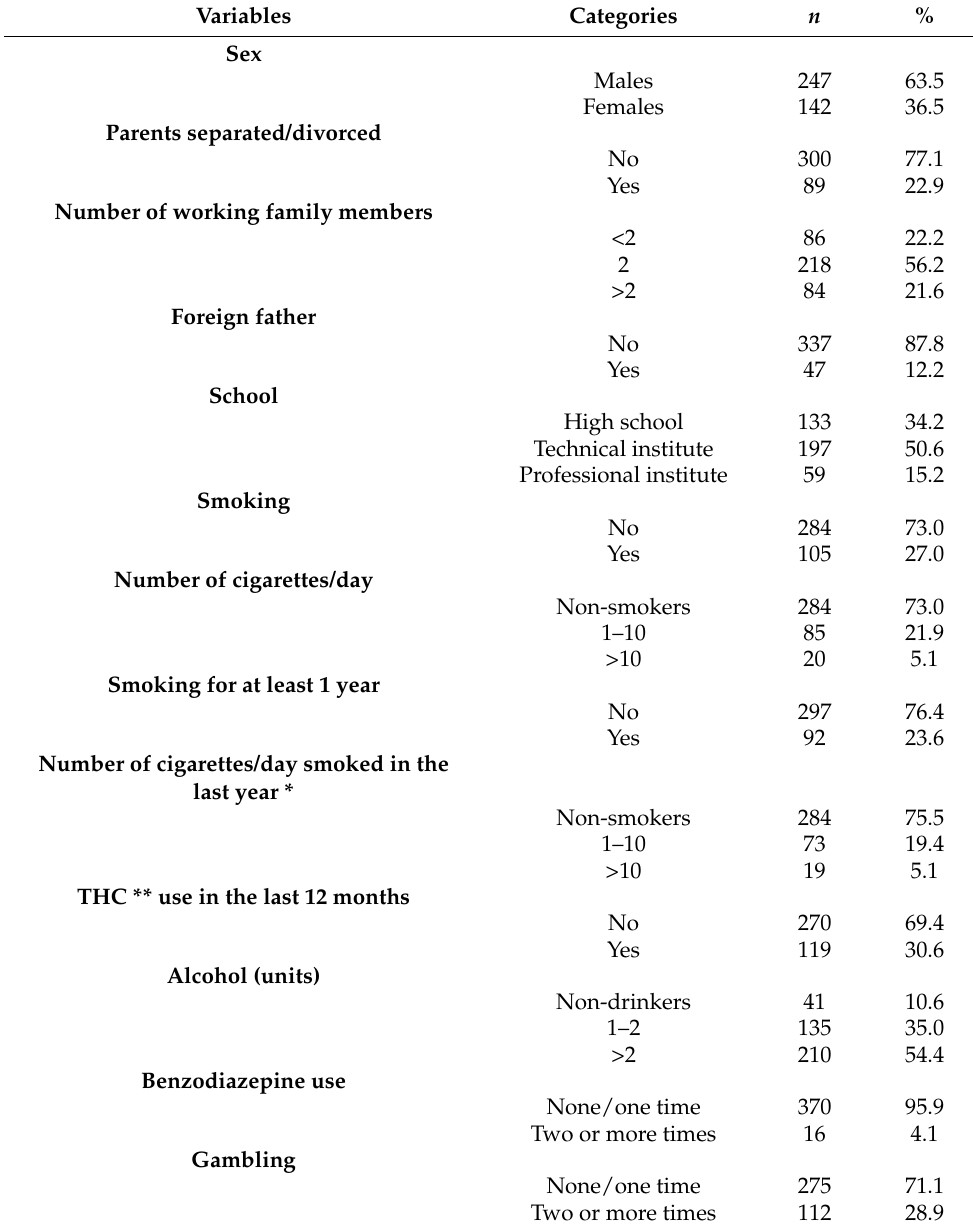
Table 1. Frequency distribution of the